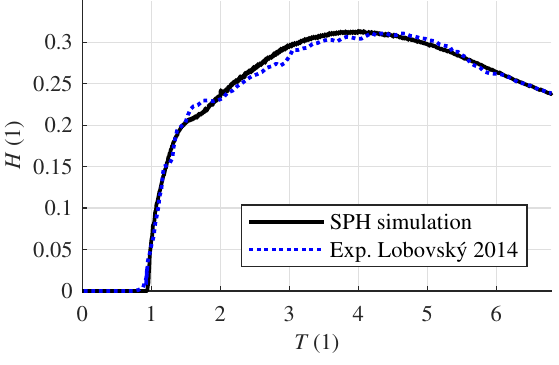
Fig. 7. Non-dimensional liquid surface height as a function of non-dimensional time at position H2. Exp. Lobovský 2014 [2].